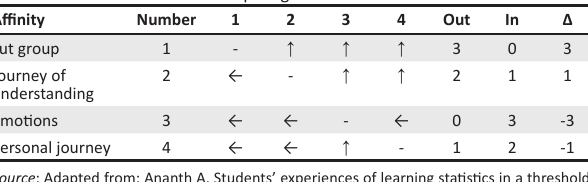
KwaZulu-Natal; 2020. The arrows for each row are then tallied. ( ↑ ) are counted as Outs and (←) arrows as Ins. The Outs minus the Ins determines the value of Δ (delta). The table is then sorted in descending order of delta (Table 3).